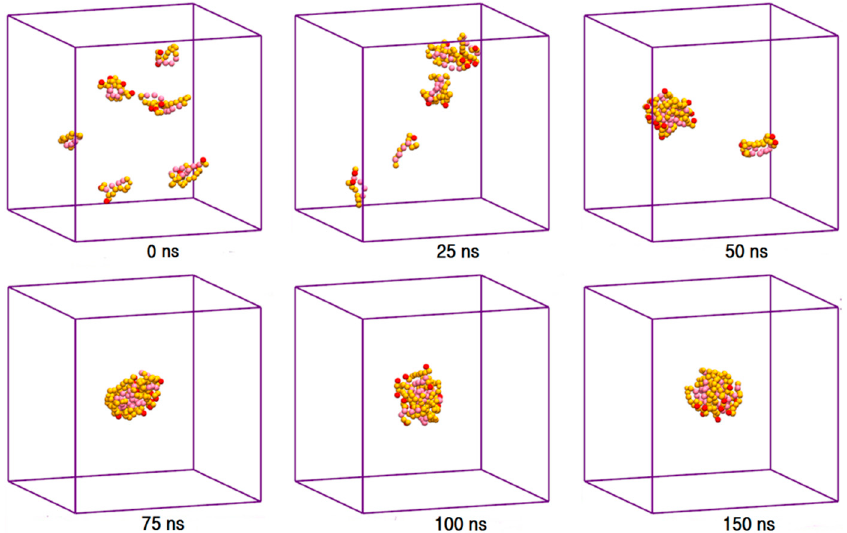
Figure 4. Trajectory snapshots of aggregation of AmB in the aqueous medium at different simulation times (water particles have been removed for clarity).